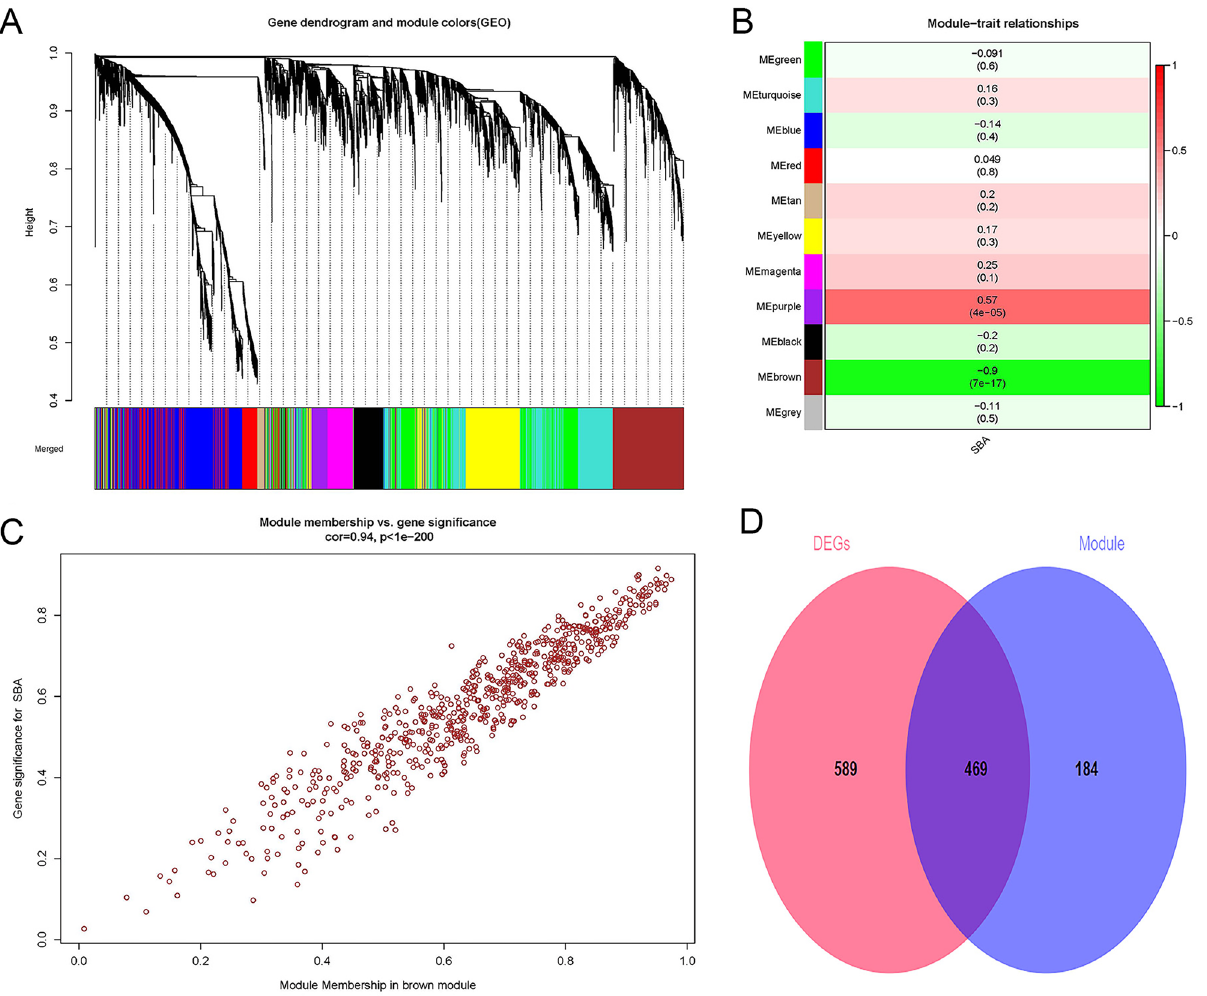
Figure 1. Weighted gene co-expression network analysis and Venn diagram. ( A ) Gene co-expression modules, represented by different colors under the gene tree. ( B ) Heatmap of the association between modules and SBA. The brown module was significantly correlated with SBA. The numbers inside and outside of the brackets represent p-values and correlation coefficients, respectively. ( C ) Correlation plot between MM (X-axis) and (GS) (Y-axis) of genes contained in the blue module. ( D ) Venn diagram showing overlapping genes between the DEGs and the genes in the brown module. SBA small bowel adenocarcinoma, GS gene significance, MM module membership. Color images are available online; DEGs, differentially expressed genes.